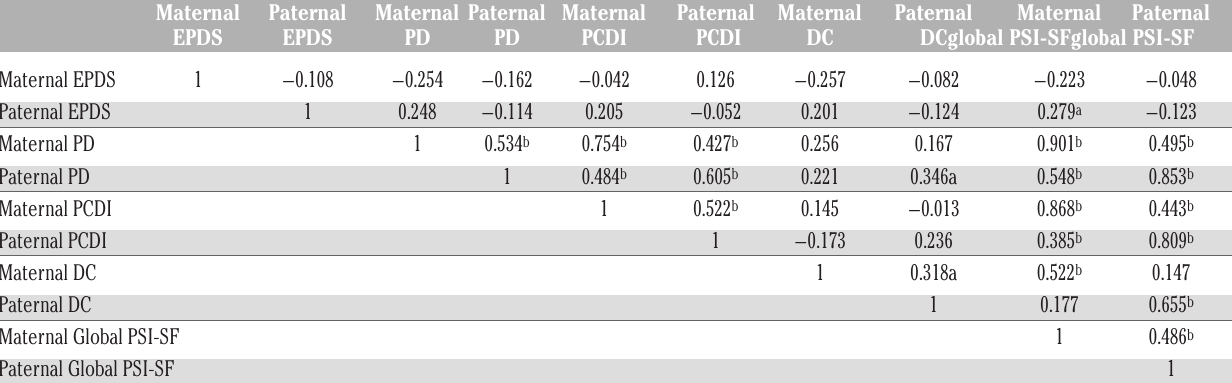
Table 3 Correlations between Edinburgh Postnatal Depression Scale and Parenting Stress Index scores in mothers and fathers sample (N=53 couples). Maternal Paternal Maternal Paternal Maternal Paternal Maternal Paternal Maternal EPDS